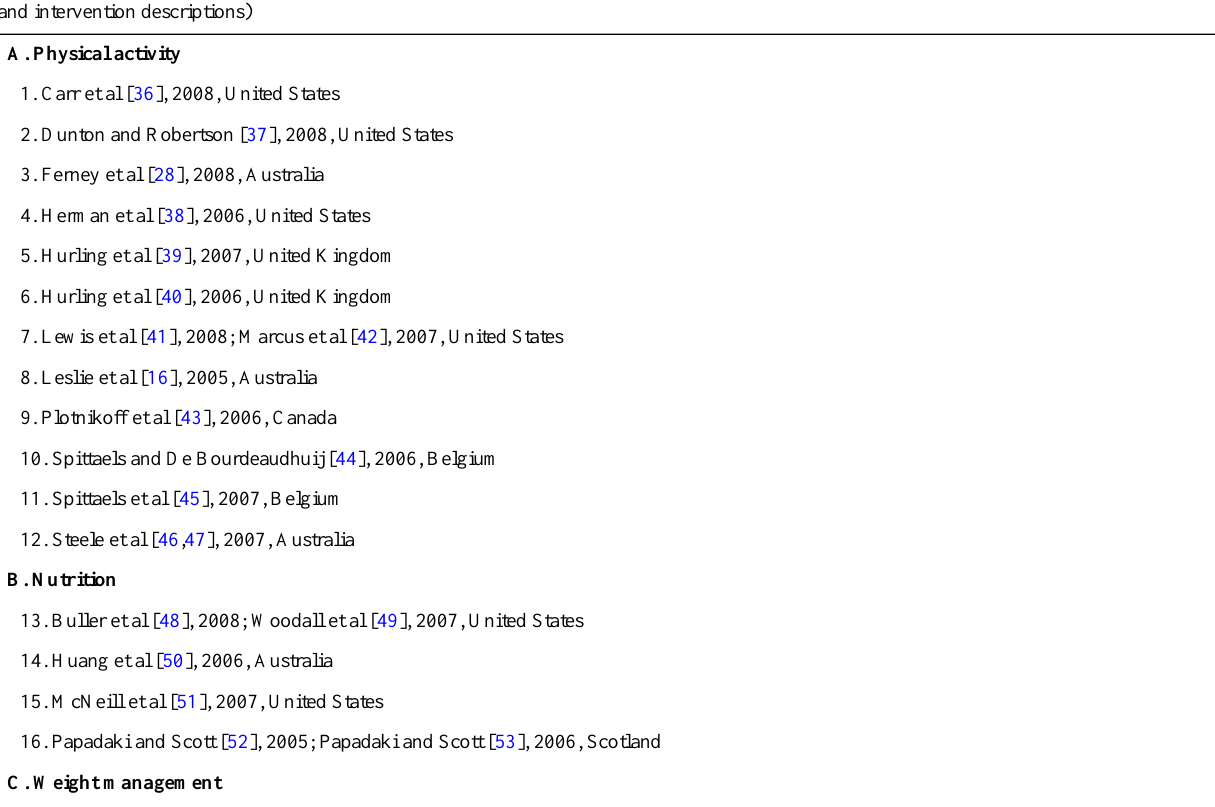
Table 1. List of included publications for review by behavior (see Multimedia Appendix 1 and Multimedia Appendix 2 for details on study characteristics and intervention